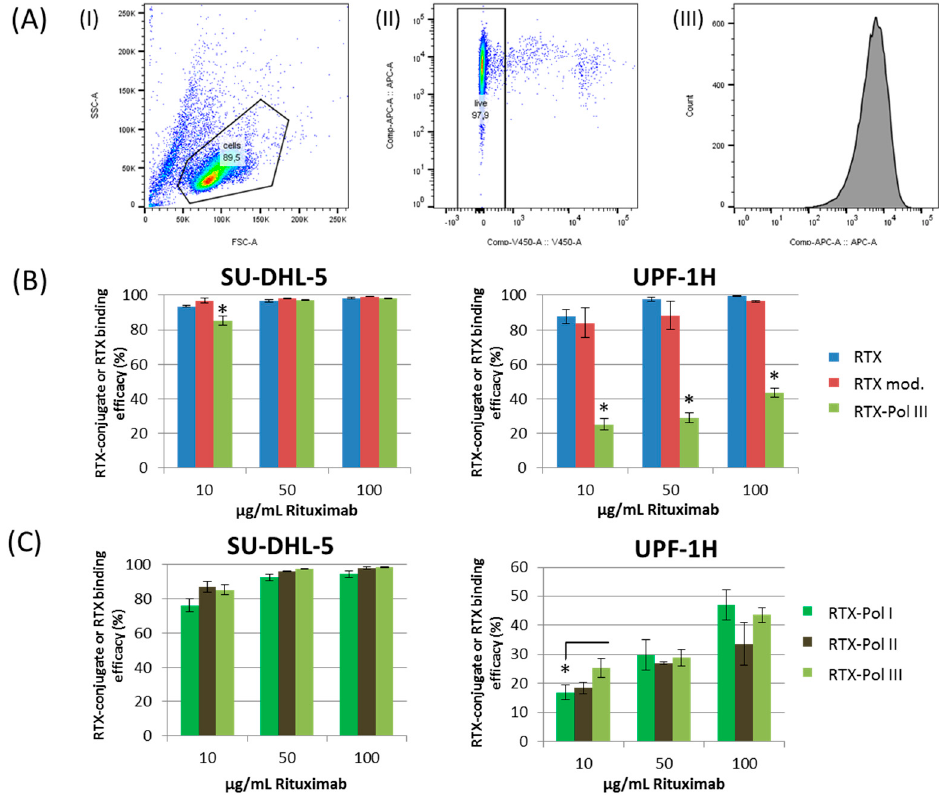
Figure 4. RTX and RTX-targeted conjugate RTX-Pol I - III binding activity to SU-DHL-5 and UPF1H cell lines measured by flow cytometry using nonspecific binding assay. ( A ) Gating strategy used for analysis: (I) cell population, (II) live cells, (III) histogram with